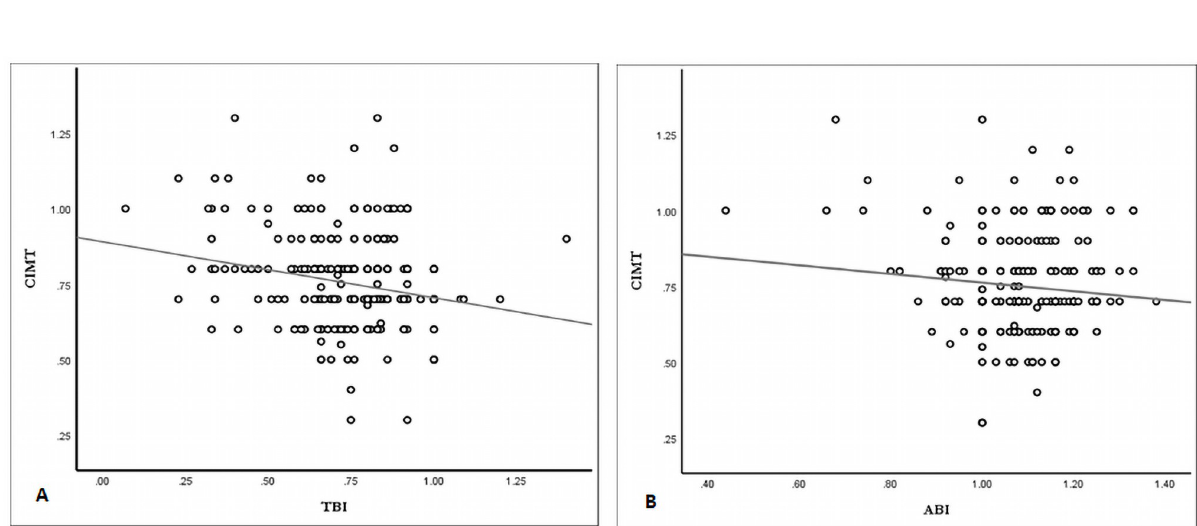
known predictor of increased cardiovascular and all-cause mortality [21, 22], incompressible leg vessel due to the medial calcification in patients with diabetes makes ABI less sensitive in this population [23, 24]. Some previous studies have shown the superiority of TBI in predicting cardiovascular outcomes compared to ABI in the special populations [25]. Wang et al. [26]